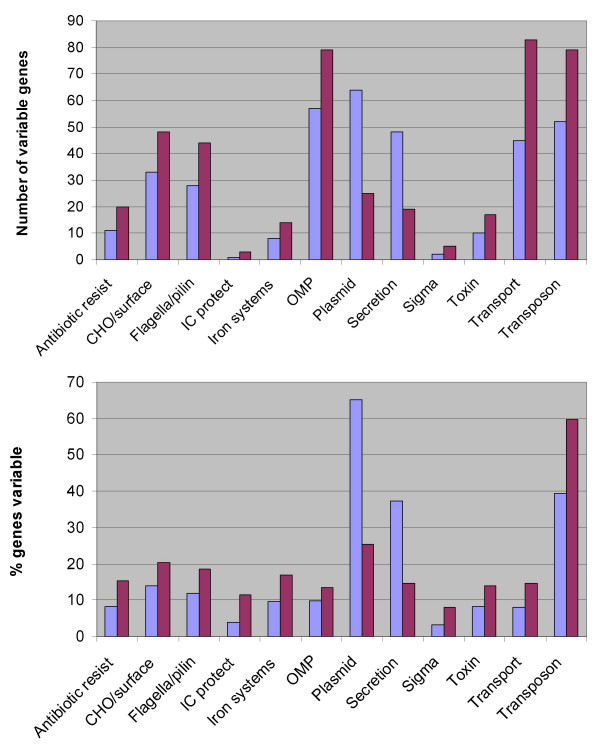
Variability of genes associated with different functional categories. Blue bars correspond to genes which were present at higher copy number (Log Ratio >1) in at least one of the A. salmonicida isolates that in A449. Red bars correspond to genes which were divergent or missing (Log Ratio <-1) in at least one of the A. salmonicida isolates. Upper panel: Number of variable genes assigned to each functional category. Lower panel: Percent of genes in each functional category which were variable.